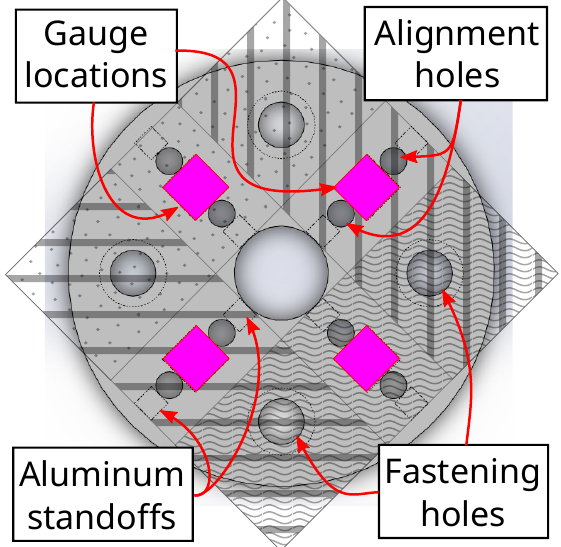
Figure 8. Geometry of disk approximated from four strain sub-units arranged in diamond-shaped configuration. Each sub-unit is distinguished by a diagonal striping pattern; subunit areas are represented by unique rectangular patterns. Pink diamonds indicate strain gauge placements. Alignment and fastening holes are rendered for reference.